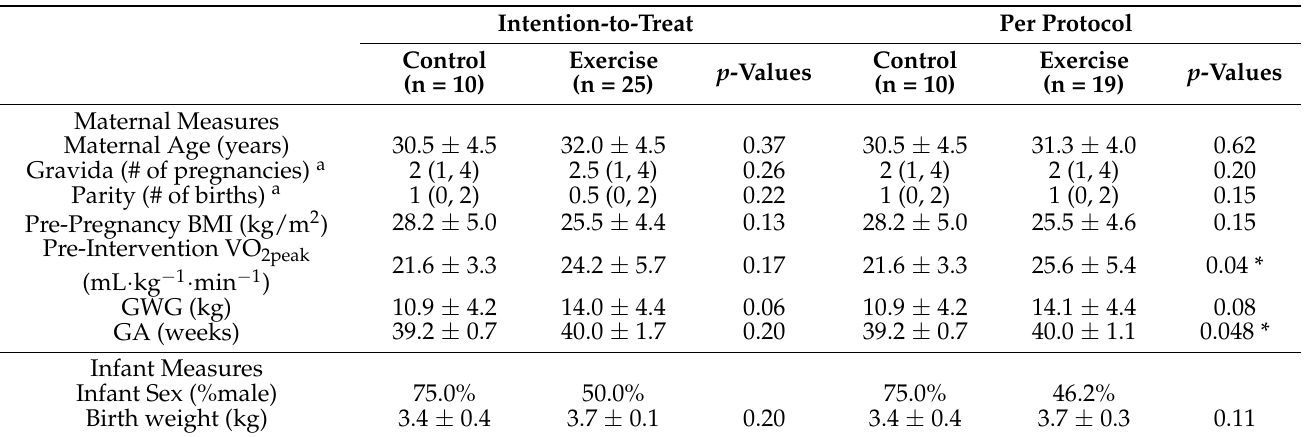
Table 1. Intention-to-treat and per protocol analysis of maternal demographics between aerobic exercise and non-exercising controls.